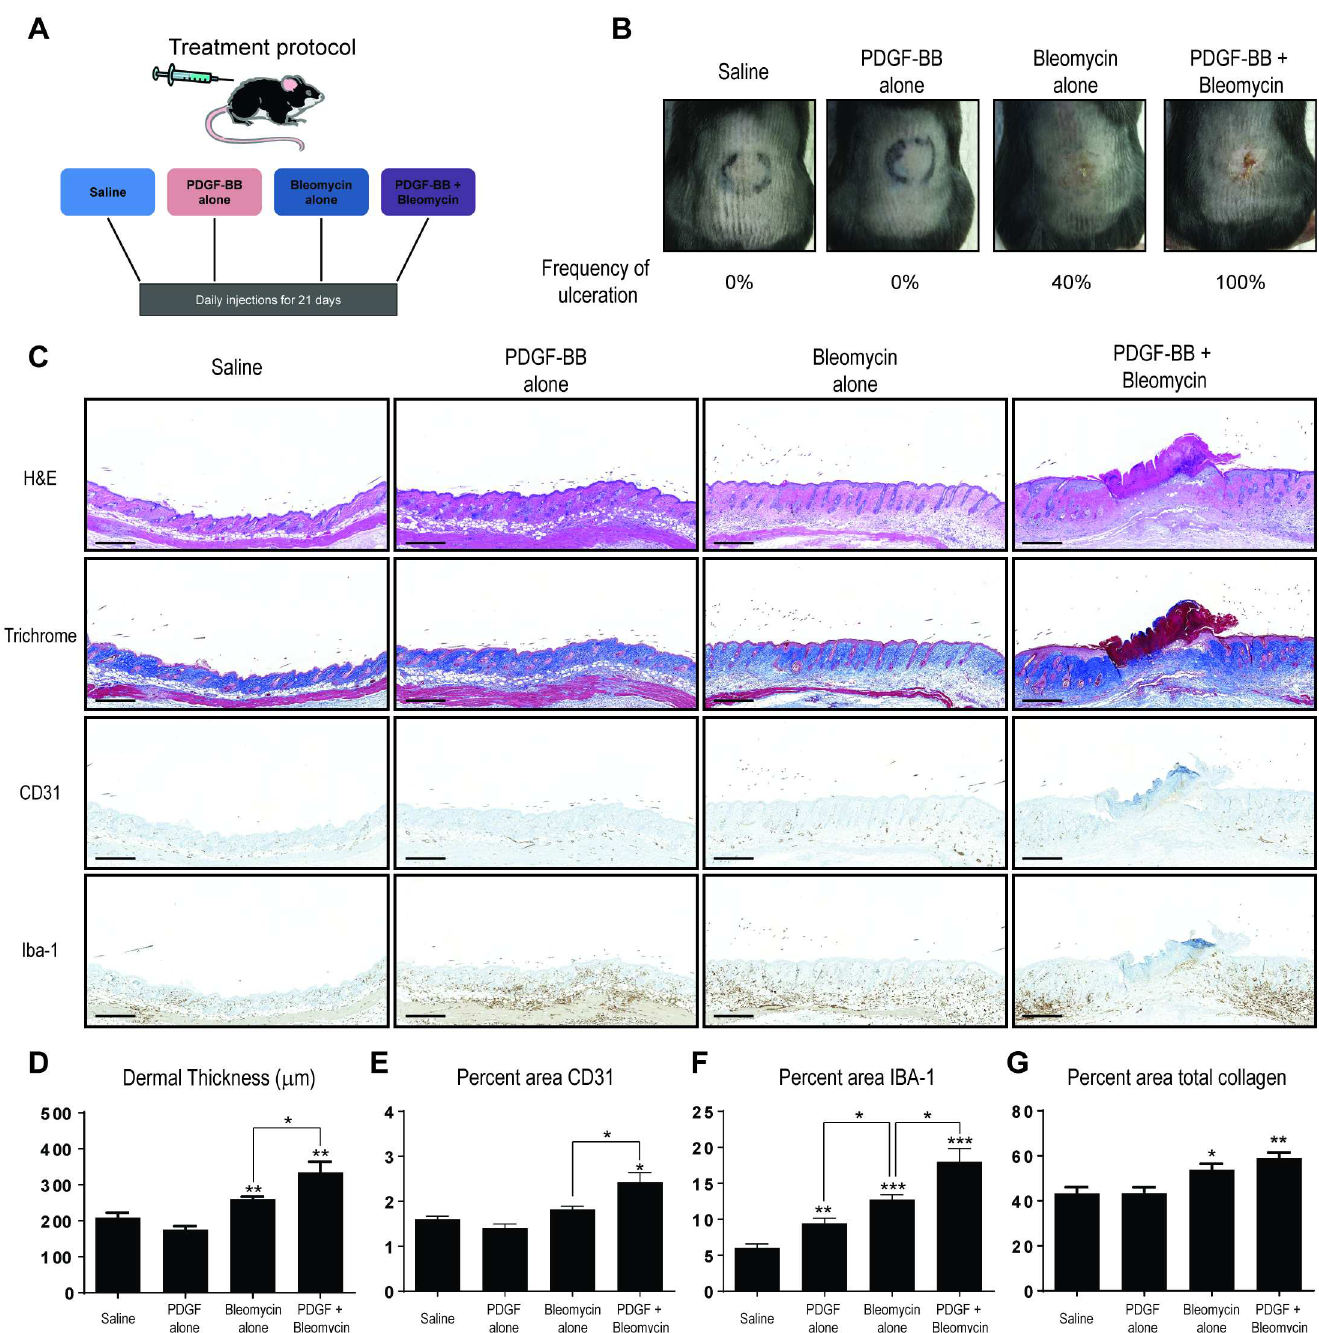
Fig 1. Exacerbated skin inflammationand ulcerationin mice treatedwithcombination of PDGF-BB+ bleomycin. (A) Outlineof experimental design.Intradermal injectionof saline, PDGF-BBalone, bleomycin alone, or PDGF-BB + bleomycin were performeddaily for 21 consecutive days on female mice at 8 weeks of age. (B) Representative photographs of skin lesions on backs of treatedmice. Frequency of ulcerationwas calculatedbased on visual examination of H&E stainedtissue sections. (C) Representative skin section of treatedmice stainedby H&E, trichrome,anti-CD31, or anti-IBA-1 immunohistochemistry(scale bar, 500 μ m).(D-G)Quantification of dermalthickness (D),percentarea CD31 (E) or percentarea IBA-1 (F) immunoreactivity, or total collagen(E) as determined by imageanalysis as described in the methods.Data is representative of at least two experiments with at least 5 mice/group/experiment. * P < 0.05, ** P < 0.01, *** P < 0.001,versus saline or betweenbracketed comparisons shown (student’s t test).